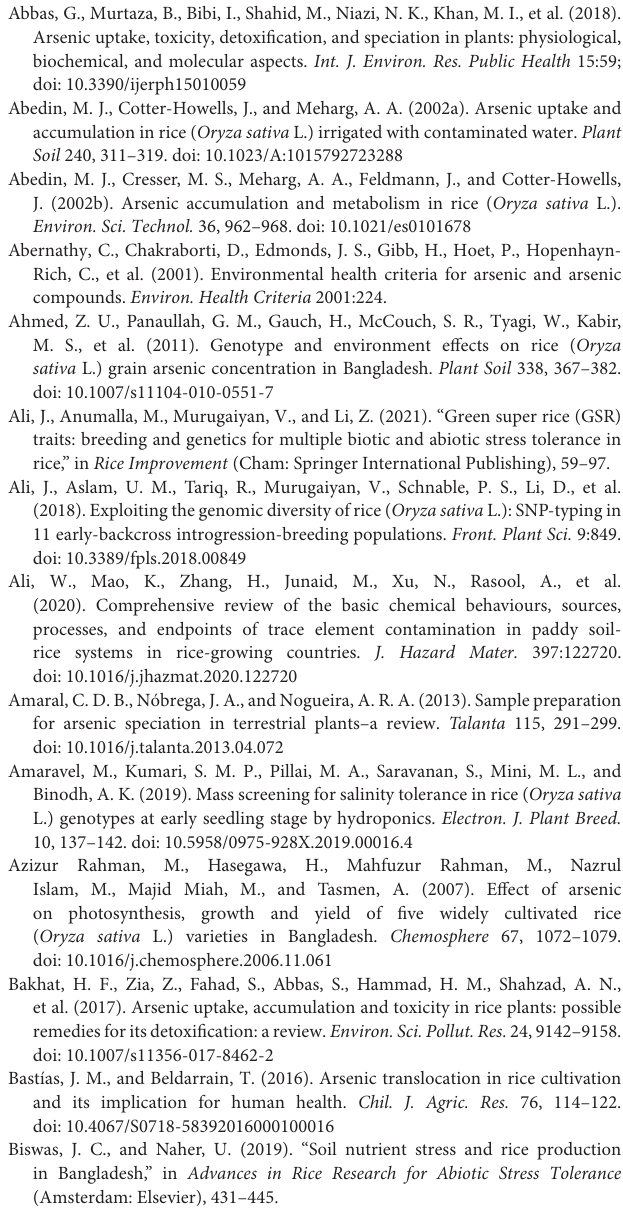
Supplementary Data 2 | Mean relative phenotypic values of traits measured under 15 ppm arsenic stress ( n = 3). Supplementary Data 3 | Mean arsenic content in brown rice harvested from field experiment ( n =